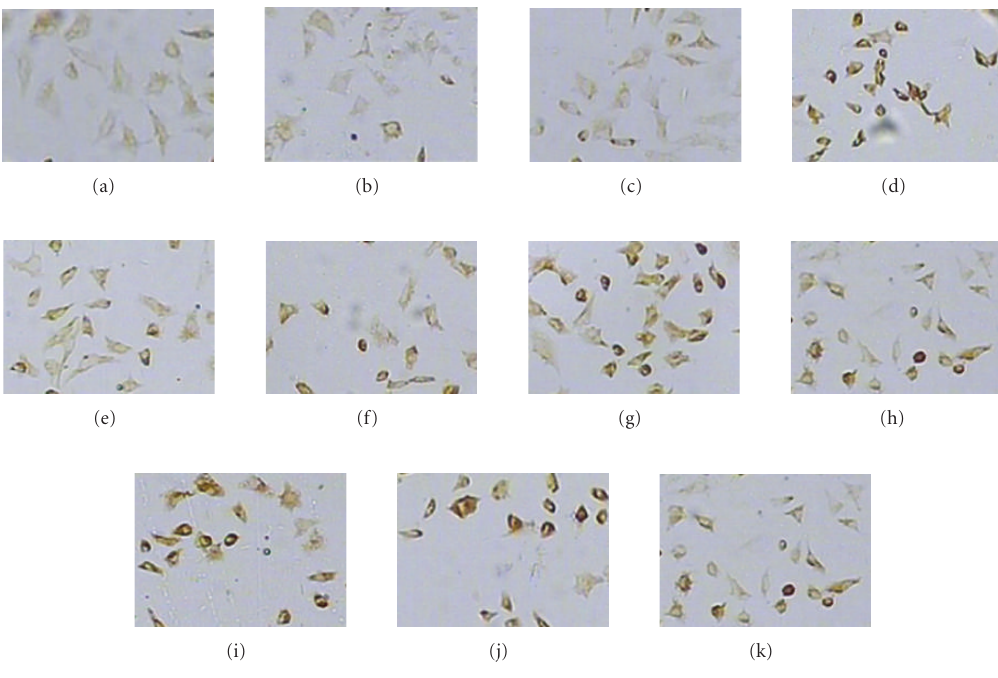
Figure 3: E ff ects of AG-490, PD-98059, PMA, or siRNA-1(STAT3) on LIF-induced expression of NK-1R detected by immunocytochem- istry (SABC × 200 ) . Immunocytochemistry was performed on cells that had been preincubated with or without AG-490, PD-98059, PMA, or siRNA-1(STAT3) and then stimulated with LIF ((a) control, (b) PD-98059, (c) AG-490, (d) LIF, (e) PMA, (f) LIF + PD-95059, (g) LIF + PMA, (h) LIF + AG-490, (i) LIF + control siRNA, (j) LIF + sham plasmid, (k) LIF + siRNA-1 against STAT3). LIF induced expression of NK-1R, which was inhibited by AG-490, PD-98059, and siRNA-1 against STAT3, but was a ff ected neither by the control siRNA nor the sham plasmid. Experiments were repeated three times with similar results, and the data was expressed as the mean ratio (positive cells number/total cells number) ± SD.